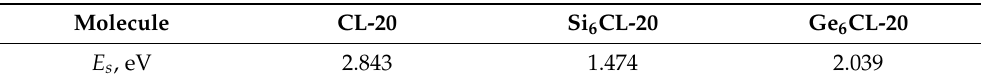
Table 5. The strain energies E s of CL-20/Si 6 CL-20/Ge 6 CL-20 molecules obtained from homodesmotic reactions (14) at the DFT/B3LYP/6-311(d,p) level of theory.